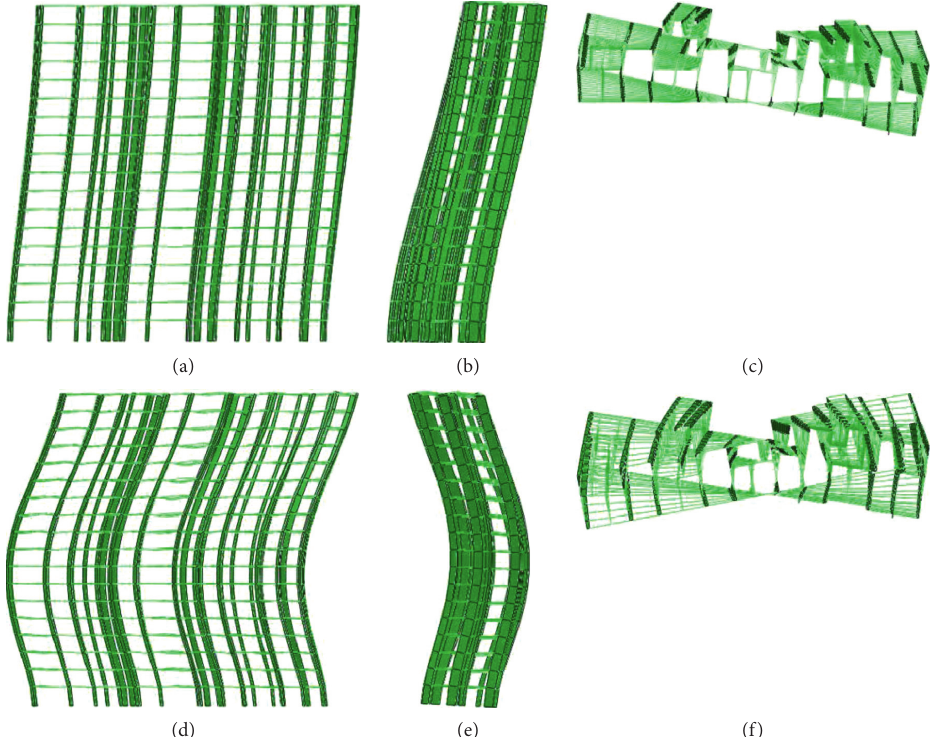
Figure 15: The lowest six vibration modes. (a) T